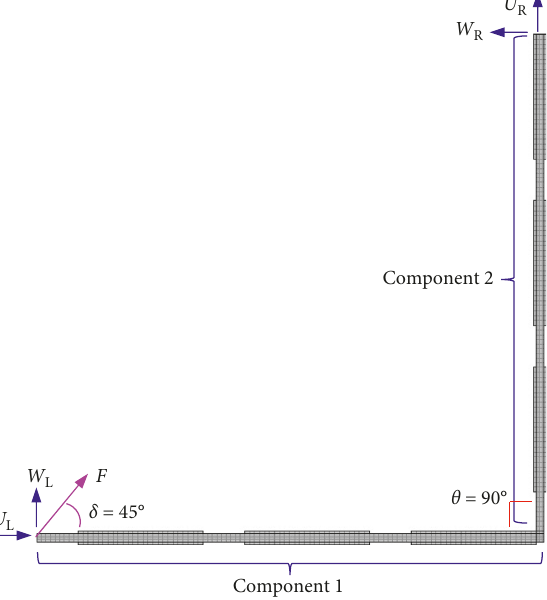
Figure 8: Finite element